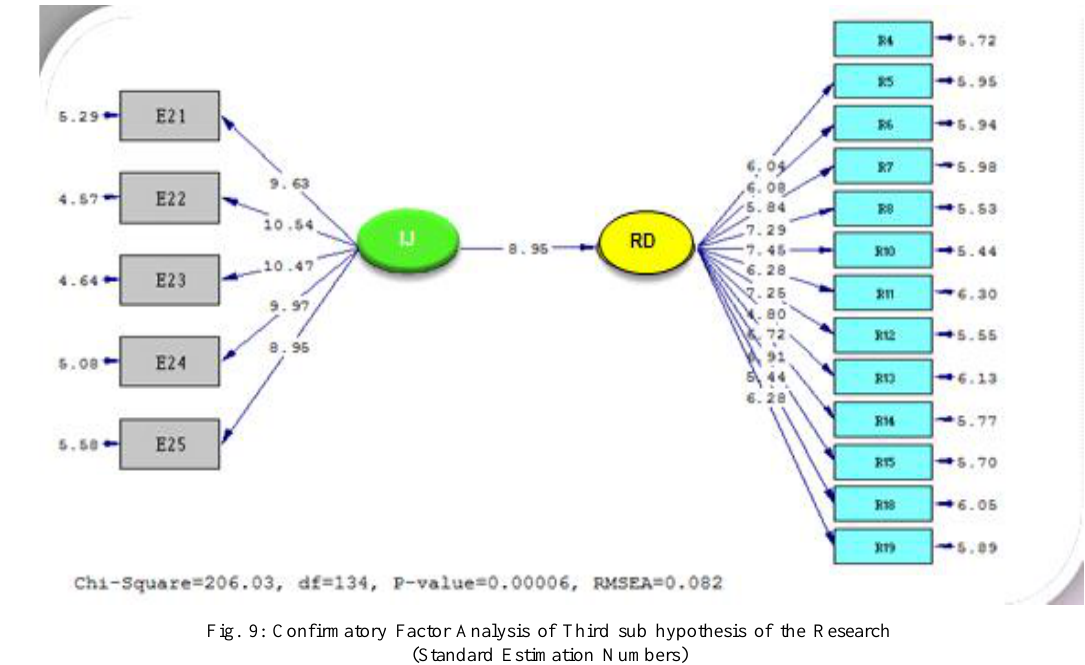
Fig. 9: Confirmatory Factor Analysis of Third sub hypothesis of the Research (Standard Estimation Numbers)